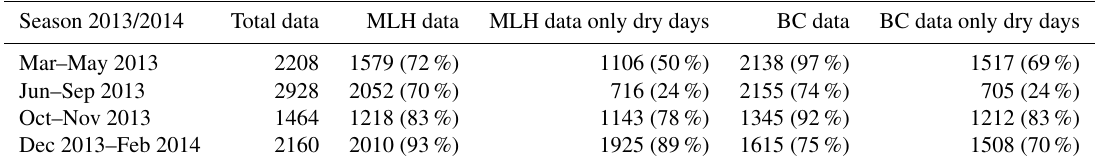
Table 1. Overview on the availability of the hourly MLH and BC data for four seasons during the period March 2013 to February